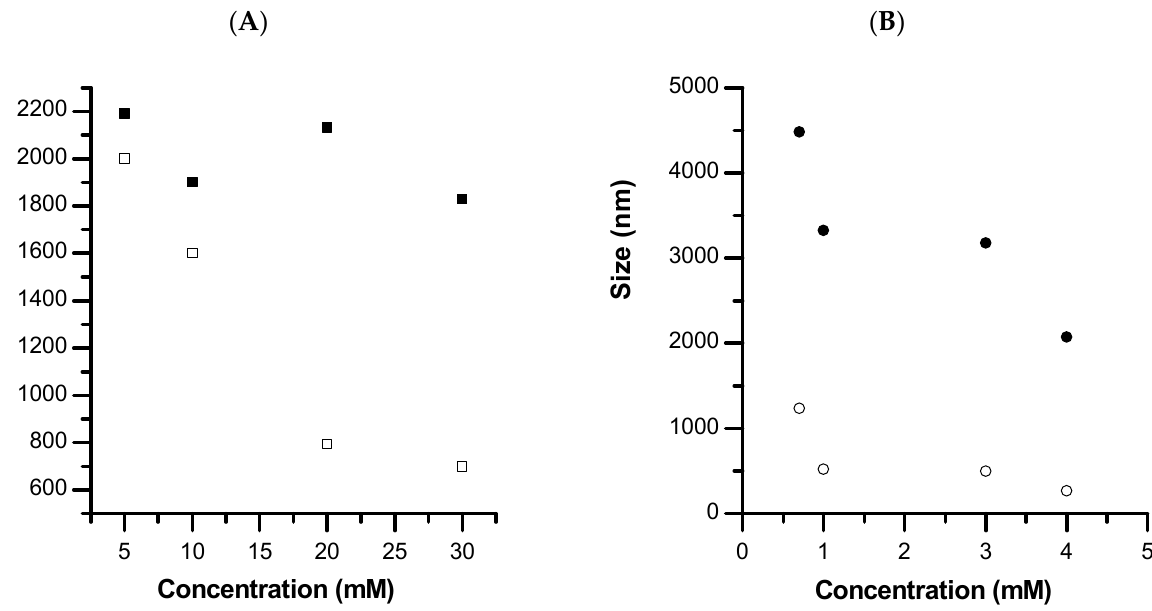
Figure 3. Size of CD-CaCO 3 particles obtained in presence of ( A ) ■ PVSA (time of precipitation reaction: 10 min), □ PVSA (time of precipitation reaction: 4 h), ( B ) ● glycerol (time of precipitation reaction: 10 min), ○ glycerol (time of precipitation reaction: 4 h).